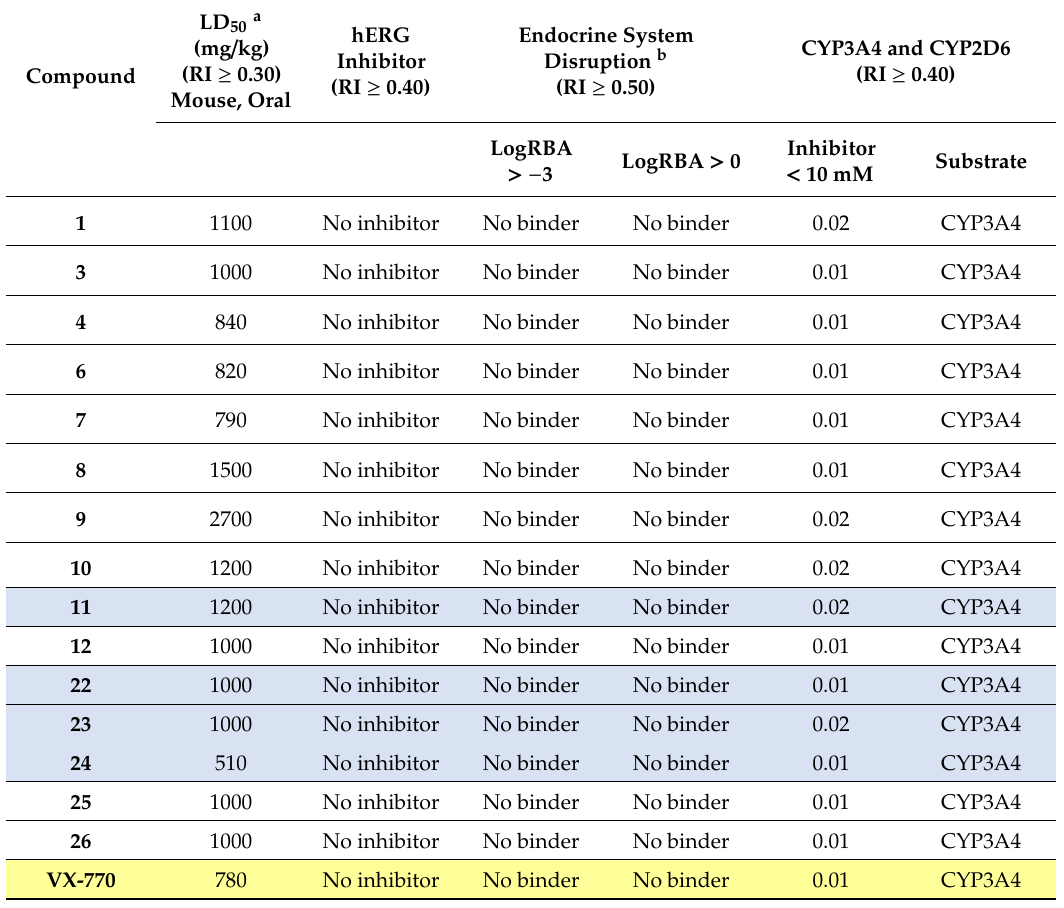
Table 6. Calculated toxicity descriptors related to metabolism, excretion and toxicity properties for the GLPG1837 analogues 1 , 3 , 4 , 6 – 12 , 22 – 26 and for the reference potentiator VX-770. The most promising GLPG1837 analogues, 11 , 22 – 24 , have been highlighted in cyan, while the reference compounds VX-770 are reported in